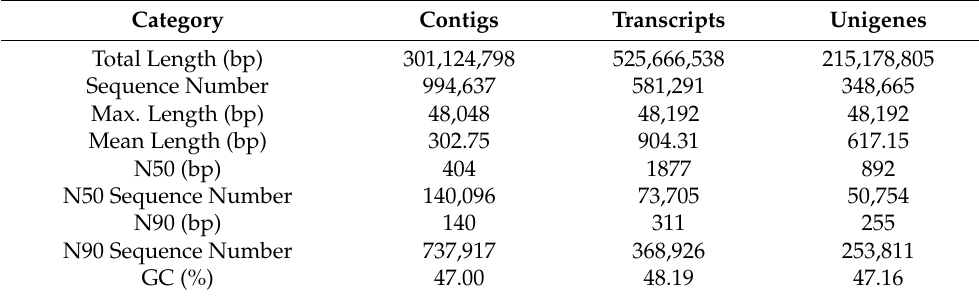
Table 4. Summary of transcript assembly.